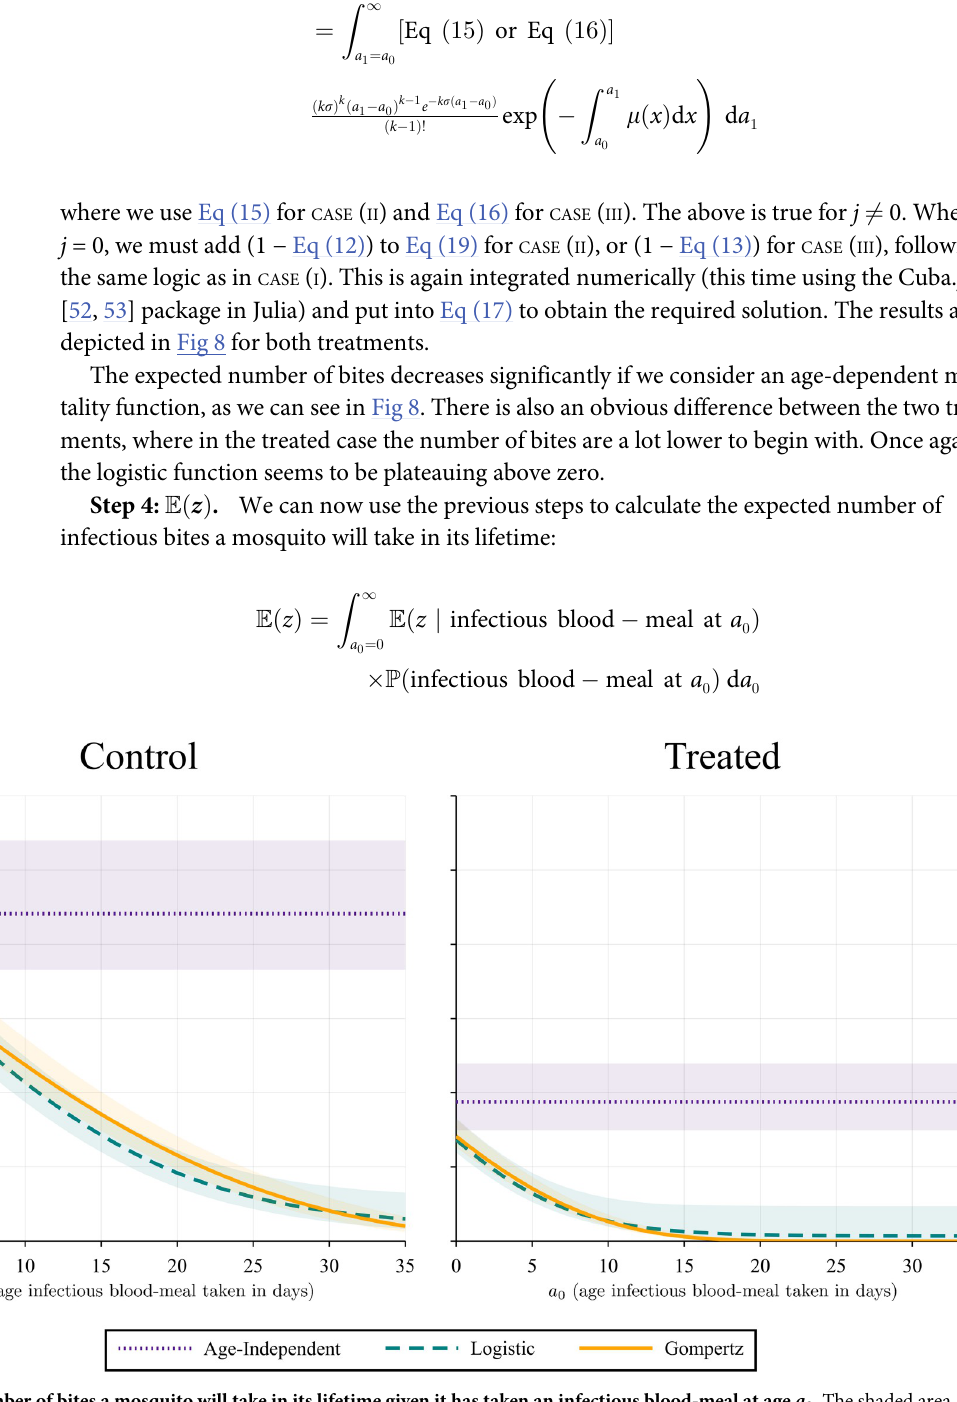
PLOS Computational Biology | https://doi.org/10.1371/journal.pcbi.1009540 September 19,